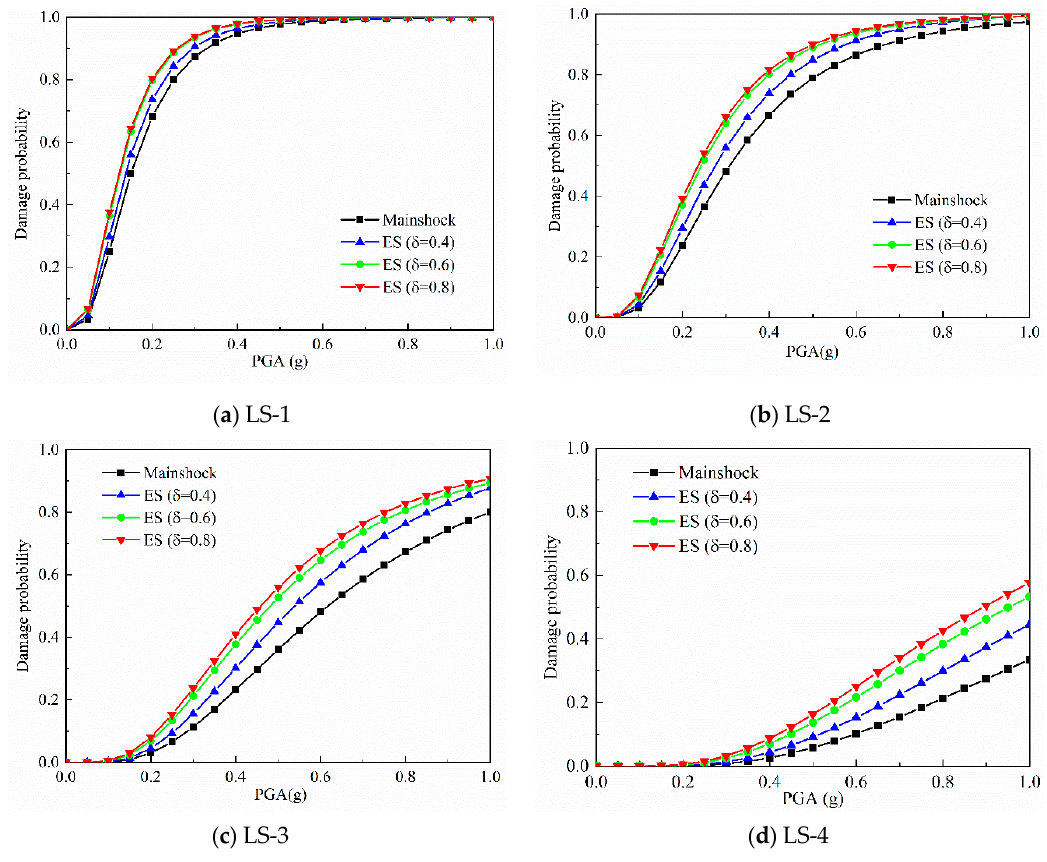
Figure 15. Fragility curves for different damage limit states.